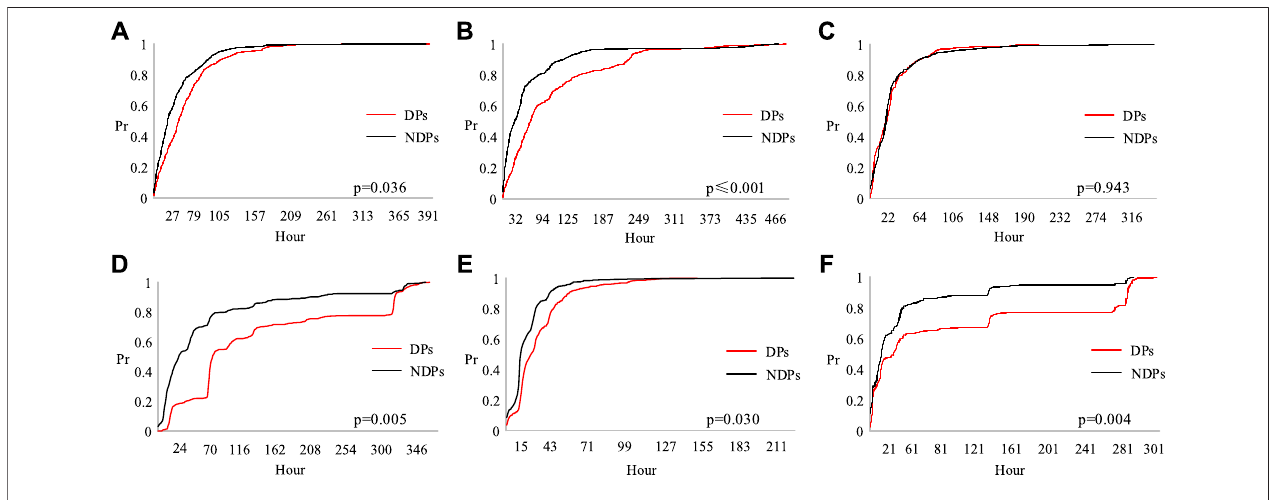
FIGURE 3 | Growth rate of debunked posts (DPs) and non-debunked posts (NDPs) in six categories of fake news over time: (A) Society, (B) Health, (C) Business, (D) Science, (E) Disaster, and (F) Politics. Notes: Science represents science and technology and Politics represents politics and fi